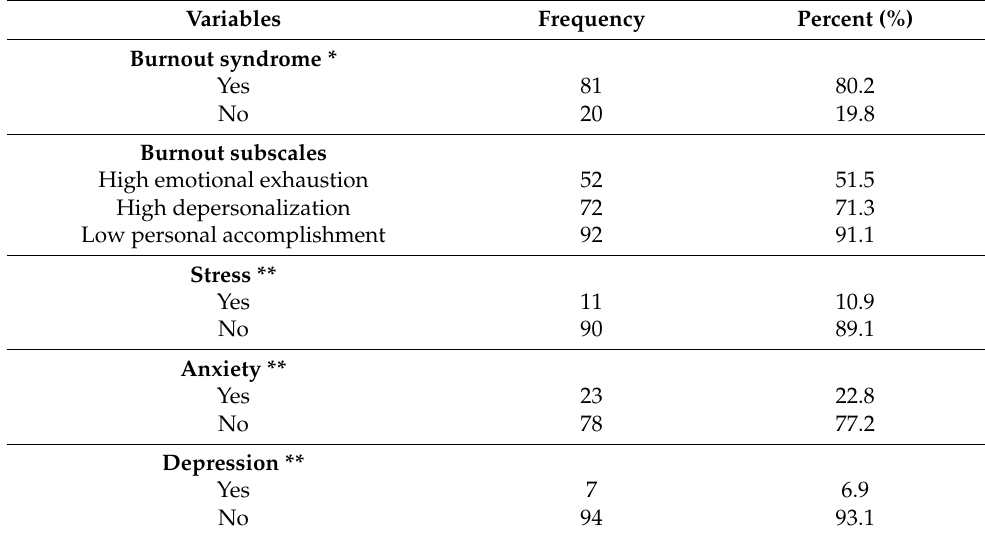
Table 3. Prevalence of burnout and mental health outcomes among the study population ( n = 101).